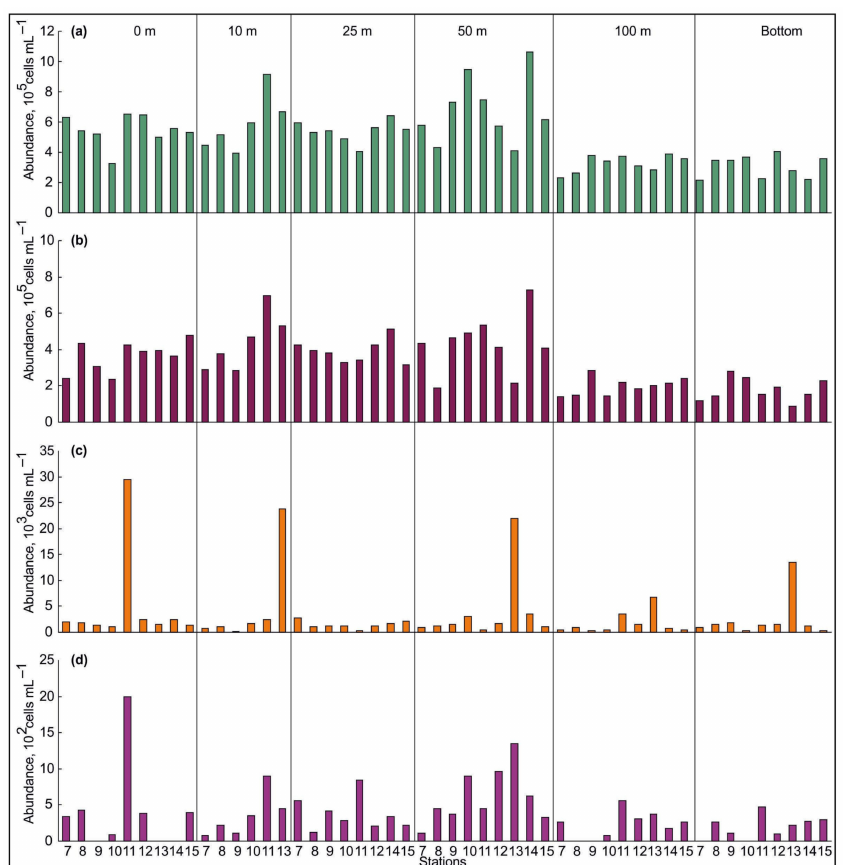
Figure 5. Abundance of bacteria (( a )—small, ( b )—ultra small, ( c )—large, ( d )—chain cells) at each station in the northeastern Barents Sea, in October 2020.